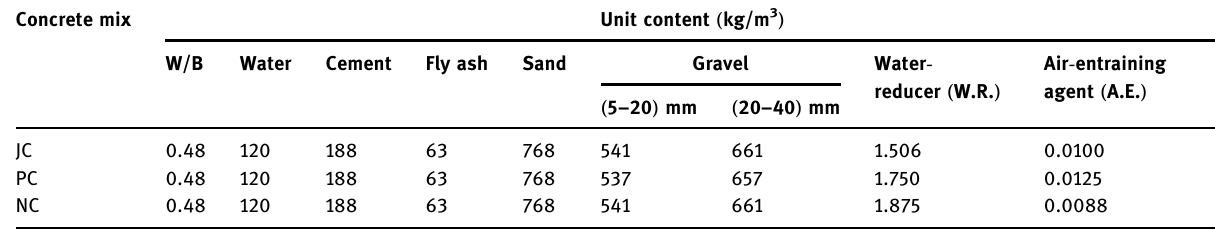
Table 4: Mix proportions of the three kinds of concretes ( kg/m 3 ) Concrete